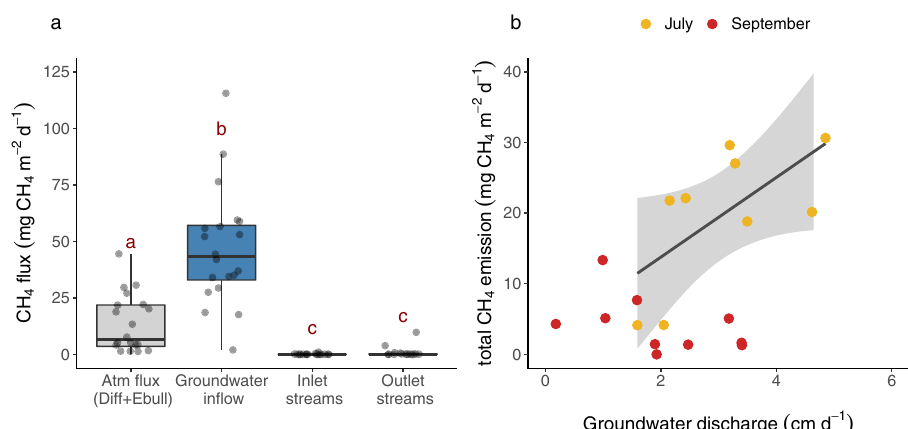
Fig. 3 CH 4 fl uxes from different sources and relationship between total CH 4 emissions and groundwater in fl ow rates. a Inputs of CH 4 to the study lakes are groundwater in fl ow and inlet streams, while outputs are emissions to the atmosphere (Atm fl ux) (by diffusion (Diff) and ebullition (Ebull)) and outlet streams. Box plots for groundwater CH 4 inputs were generated by considering median values reported at each lake for each season. The boundaries of each box plot indicate the 25th and 75th percentiles of these fl uxes, and the solid line in each box marks the median. Different lower-case letters indicate differences between water sources. The data used to generate the box plots is represented with gray circles. b In summer, as groundwater in fl ow rates increase, higher atmospheric CH 4 emissions are found. The solid line represents the linear regression between total CH 4 emissions and groundwater in fl ow rates ( y = (6.5 ± 1.7) x + (0.1 ± 6.2), df = 8, F = 15, p < 0.005). The shaded area represents 95% con fi dence